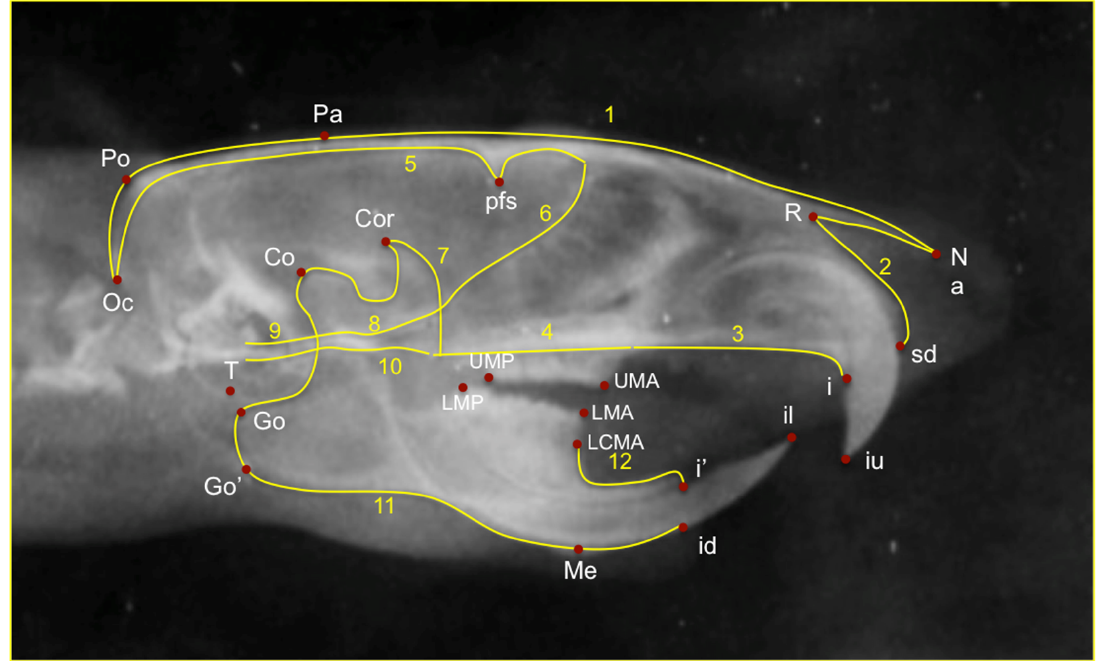
Figure 2. Traced lateral X-ray for Geometric morphometric analysis. 12 curves and 90 landmarks, of which 74 were semilandmarks and 16 were fixed landmarks were used for morphometric analysis. The fixed landmarks are the most posterior-superior point on the mandibular condyle (Co), the most posterior point of the angular process of the mandible (Go), the point on the most inferior contour of the angular process of the mandible (Go’), most prominent point between incisal edges of lower incisors (il), most prominent point between incisal edges of upper incisors (iu), most posterior point of lower molars (LMP), most anterior point of lower molars (LMA), the most inferior-anterior point